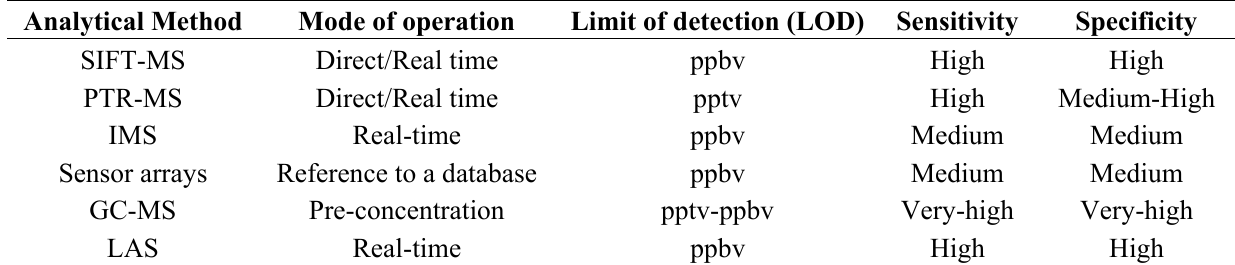
Table 1. A comparison of the characteristics of the available breath research techniques. Analytical